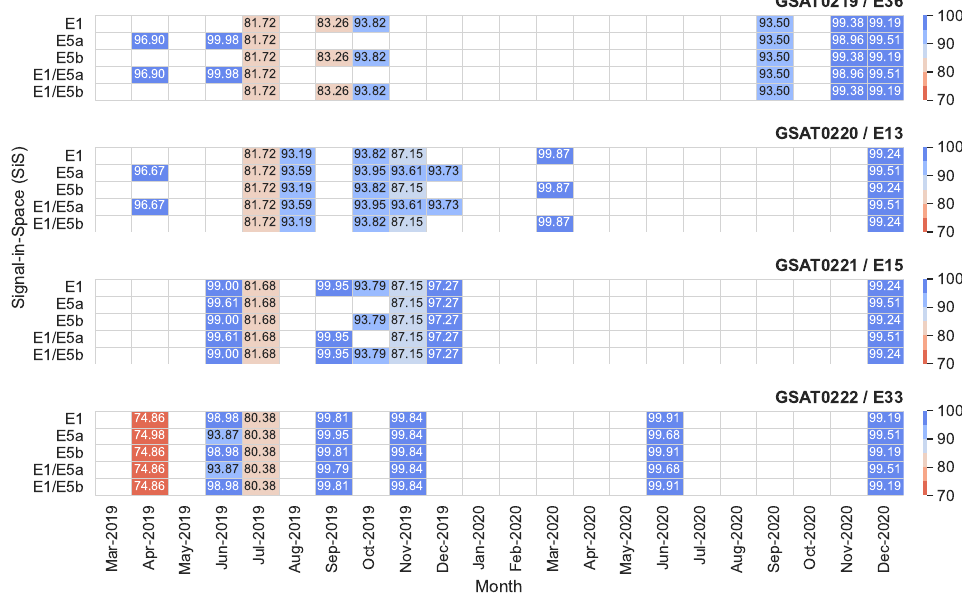
Figure 11. SiS availability per-satellite transmitting a healthy signal from March 2019 to December 2020. Availability is computed starting with the first complete month after the satellites were declared operational. The values lower than 100% are shown numerically for guidance. A white cell denotes 100% SiS availability. [Unit: